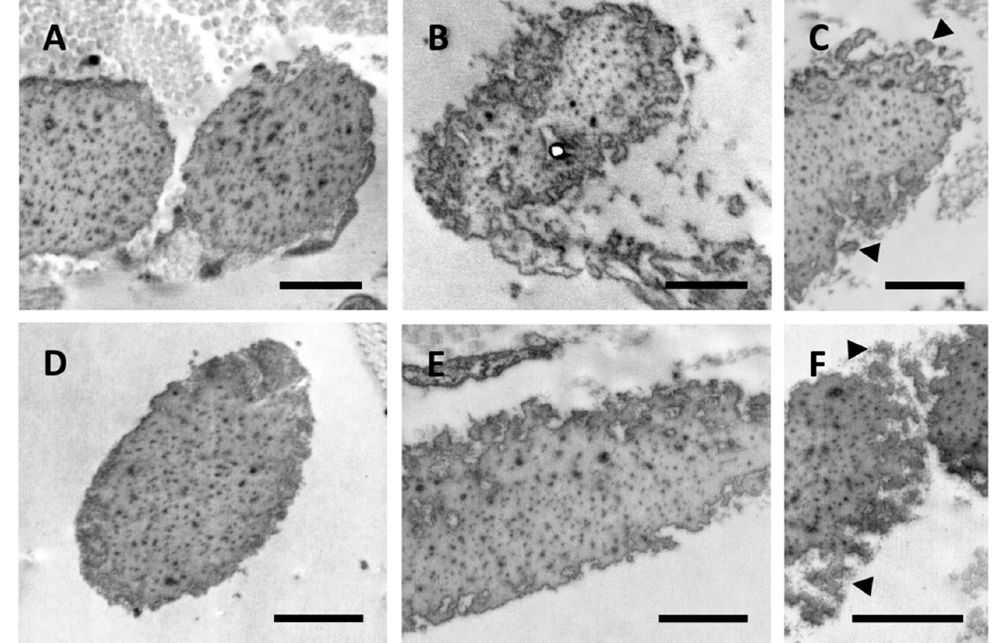
Figure 2. Electron microscopy images obtained from the skin of a 37- and a 52-year-old healthy subject ( A , D , respectively) and from clinically unaffected skin of a 37- and a 50-year-old PXE patient ( B , C and E , F , respectively). Elastic fiber globules are detached from the main fiber (arrowhead) ( C , F ). Scale bar = 1 µm.